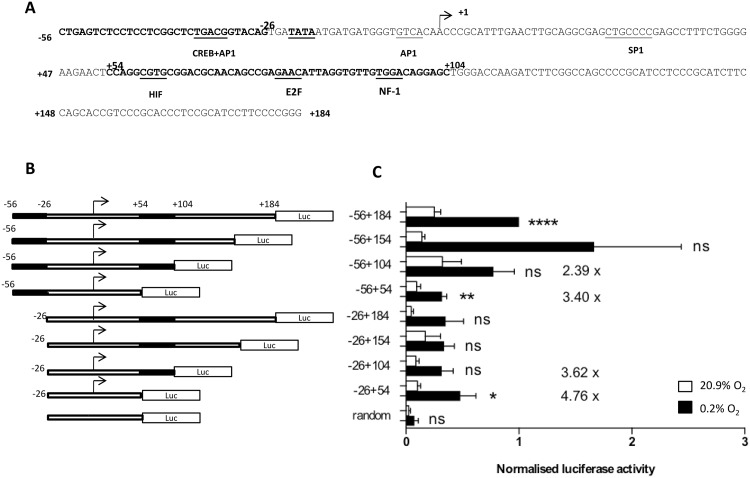
Activity of versican promoter luciferase reporter constructs in normoxia and hypoxia in HMDM.
(A) Putative transcription binding sites for hypoxia inducible factor (HIF), cAMP responsive element binding (CREB), activator Protein 1 (AP1), SP1, nuclear factor 1 (NF-1) and E2F within the 240 bp (-56+184) versican promoter sequence. The -56 to -26 and +54 to +104 sequences which are important for high level expression are in bold. (B) Schematic diagram of versican promoter or random 26mer luciferase reporter constructs used. (C) activity of versican promoter or random 26mer luciferase reporter constructs in HMDM after 5d incubation in normoxia (20.9% O2), or hypoxia (0.2% O2). Data from an average of 6 independent experiments with each construct, minimum n = 3 for each construct, are expressed as means ± SEM. Luciferase data were normalized to protein levels. Data assessed for significant increase in hypoxia compared to random construct control using two-tailed t tests, *** = p <0.001 ** p < 0.01,* = p <0.05, ns = not significant.